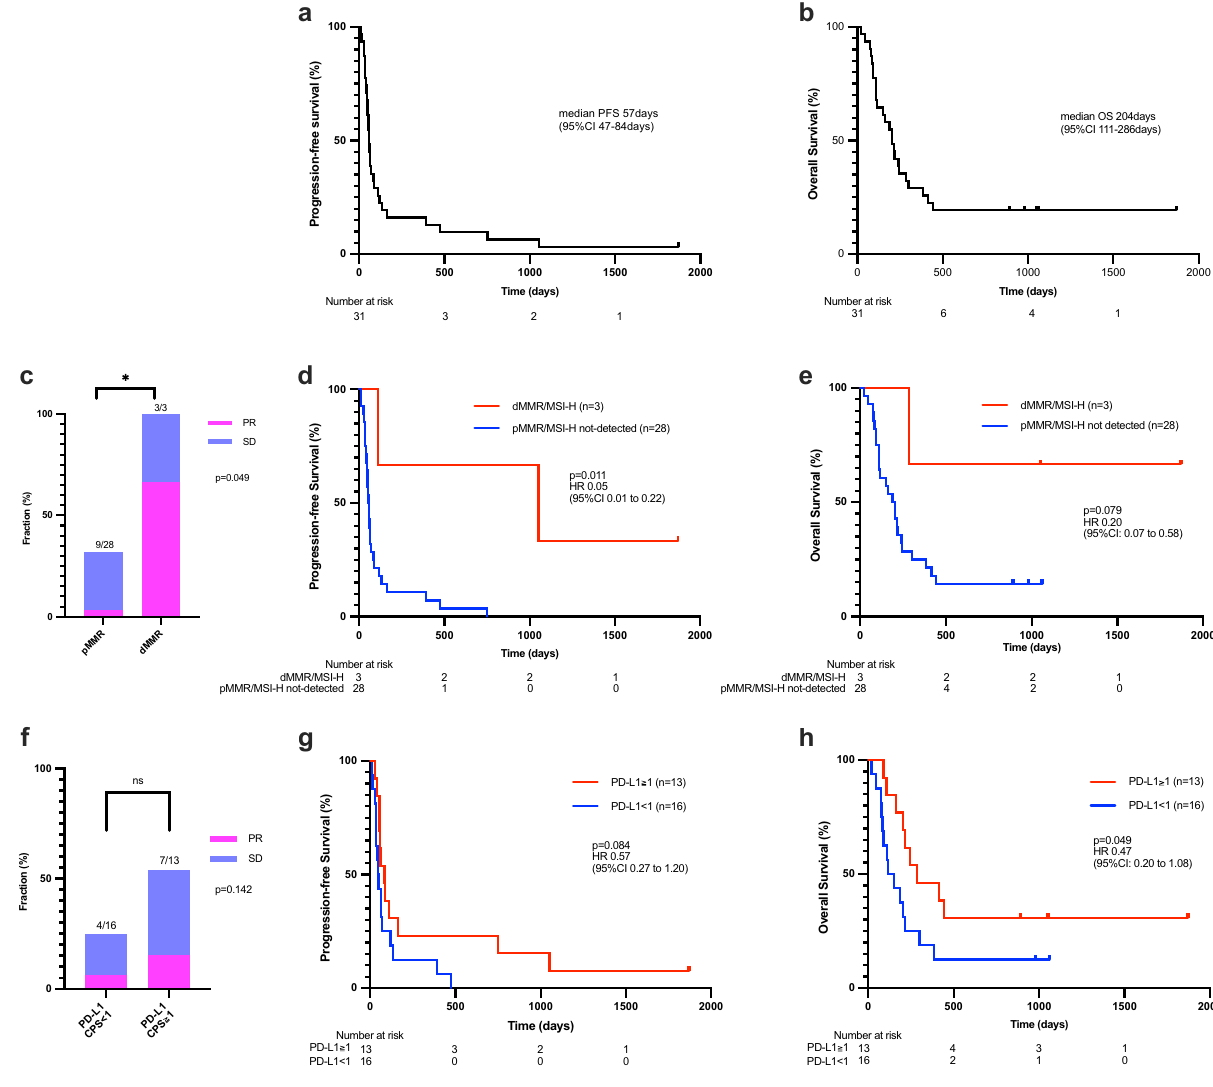
Figure 2. The clinical outcome of gastric cancer patients who received nivolumab monotherapy in the overall population, and its association with tissue-based biomarkers including dMMR and PD-L1 CPS. Kaplan–Meier estimates of progression-free survival (PFS, a ) and overall survival (OS, b ) of overall gastric cancer patients treated with nivolumab monotherapy. Disease control rate (DCR, c ), and Kaplan–Meier estimates of PFS ( d ), as well as OS ( e ), according to dMMR status. Disease control rate (DCR, f ), and Kaplan–Meier estimates of PSF ( g ), as well as OS ( h ), of patients stratified by PD-L1 CPS of 1. dMMR mismatch repair-deficient, MSI-H microsatellite instability-high, MSS microsatellite stable, PD-L1 CPS programmed death ligand 1 combined positive score, PR partial response, SD stable